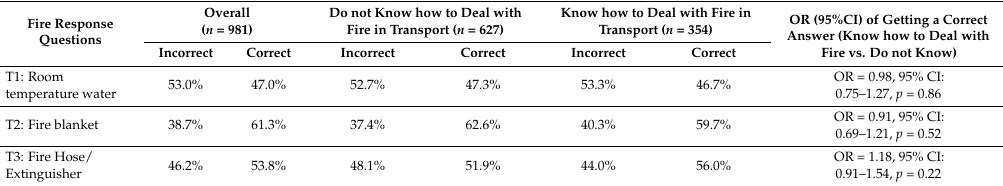
Table 5. Knowledge test of fire emergency